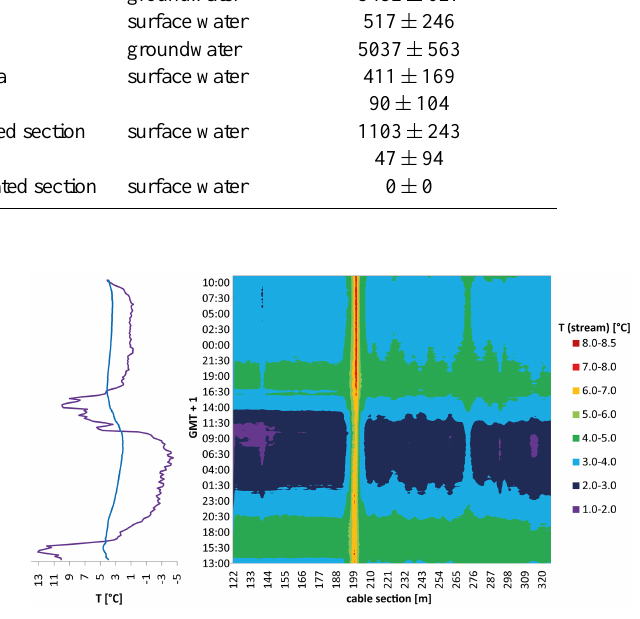
Figure 8. Air and stream reference temperature (line diagram, left side; purple and blue line, respectively) and surface water temper- atures (colour plot, right side) of the Röthenbach on 17–19 Febru- ary 2014. The x axis of the colour plot shows the sections of the fibre-optic cable in metres; the colours represent the surface water temperatures in ◦ C. Thereby, each coloured line on the x axis, from cable section 140 to 325m, represents one measurement. The y axis states the time of the